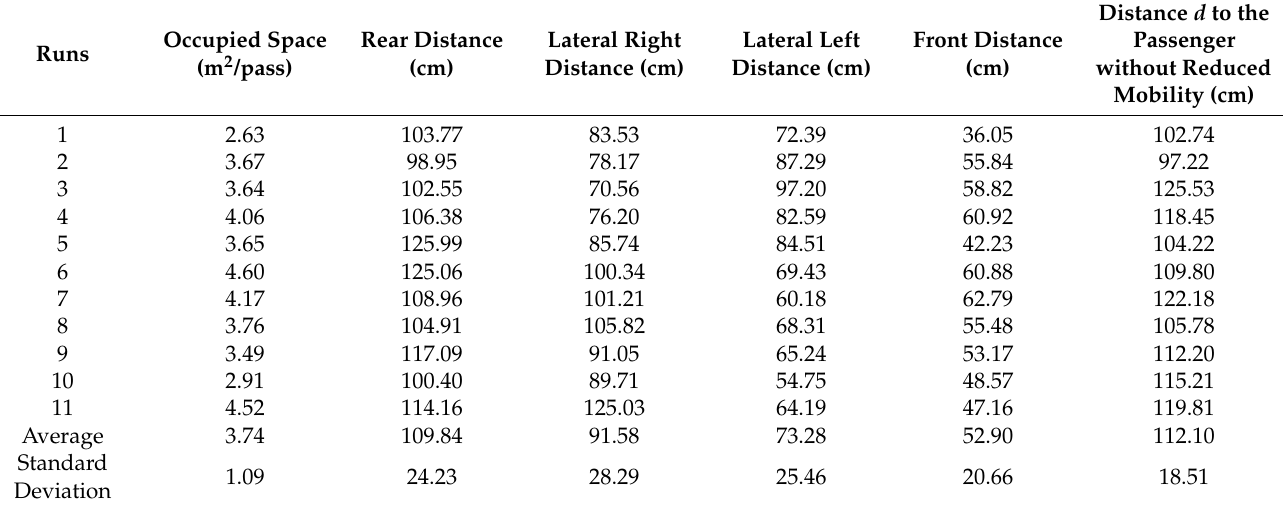
Table 6. Average space occupied by passengers without reduced mobility alighting the